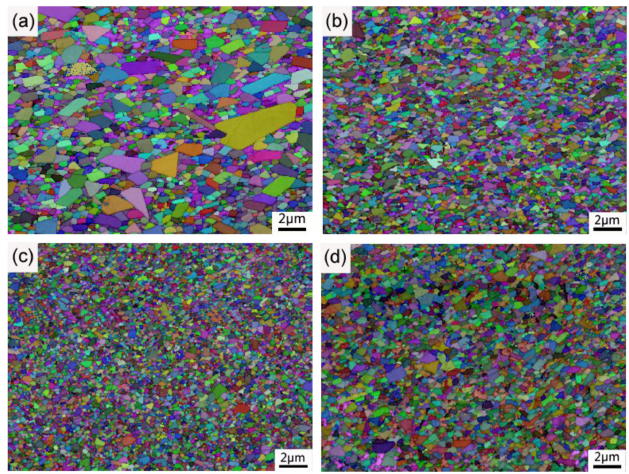
Figure8. Electronbackscattereddi ff raction(EBSD)mapsininversepolefigurecolors, inwhichthecolors correspond to the crystal orientations of WC grains, for the WC–10 wt. % Co investigated cemented carbides sintered at 1410 ◦ C for 1 h. ( a ) WC–10Co; ( b ) WC–10Co–0.8Cr 3 C 2 ; ( c ) WC–10Co–0.8VC; ( d ) WC–10Co–0.8TaC.